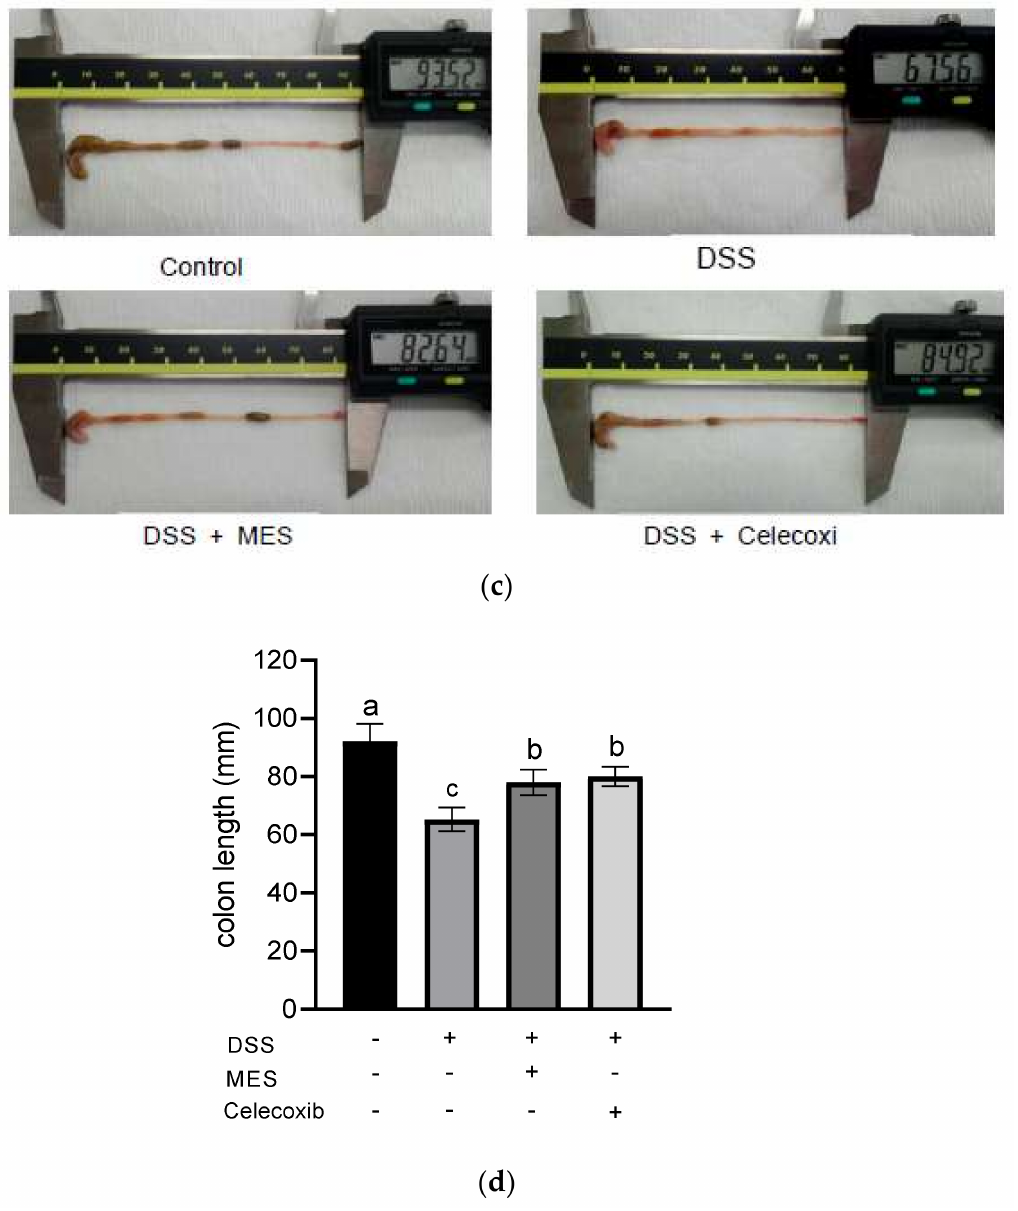
Figure 2. MES supplementation ameliorates symptoms of DSS-induced colitis. ( a ) Body weight from day 0 to day 10. ( b ) Disease activity index (DAI) scores. ( c ) Gross picture of colons, measured in mm. ( d ) Quantification of length of colons from each group mice obtained on Day 11. All data are expressed as mean ± SD. All data are expressed as mean ± SD. Bars with no common letters are significantly different ( p < 0.05). DSS: dextran sulfate sodium; MES: meroterpenoid-rich ethanoic extract of a brown algae, Sargassum macrocarpum